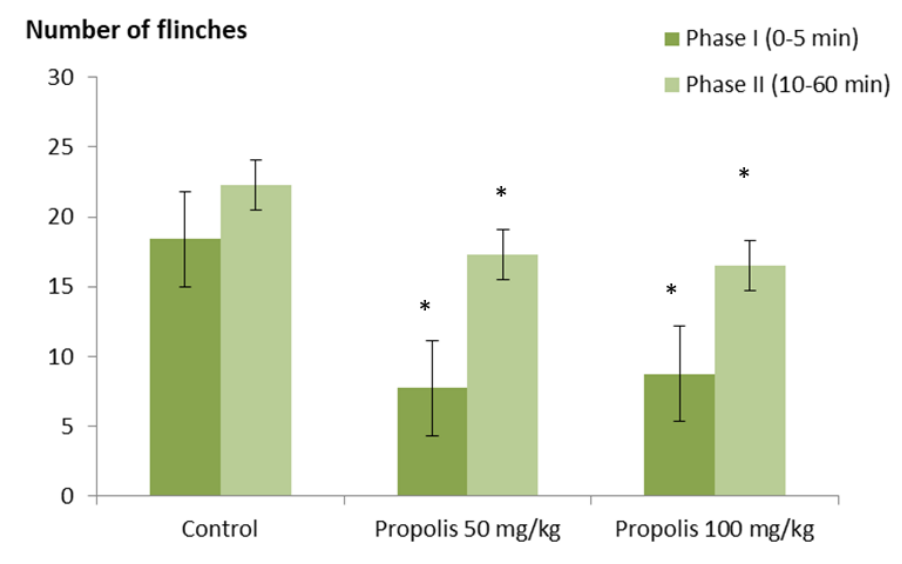
Figure 1. Antinociceptive effect of green Brazilian propolis alcohol extract (P50 and P100) in the infrared test in the rats. The values expressed are mean ± SEM, ( n = 6).* p < 0.05: significantly different for treated (P50 and P100) compared to the control groups as determined by ANOVA analysis followed by multiple comparison post hoc test.